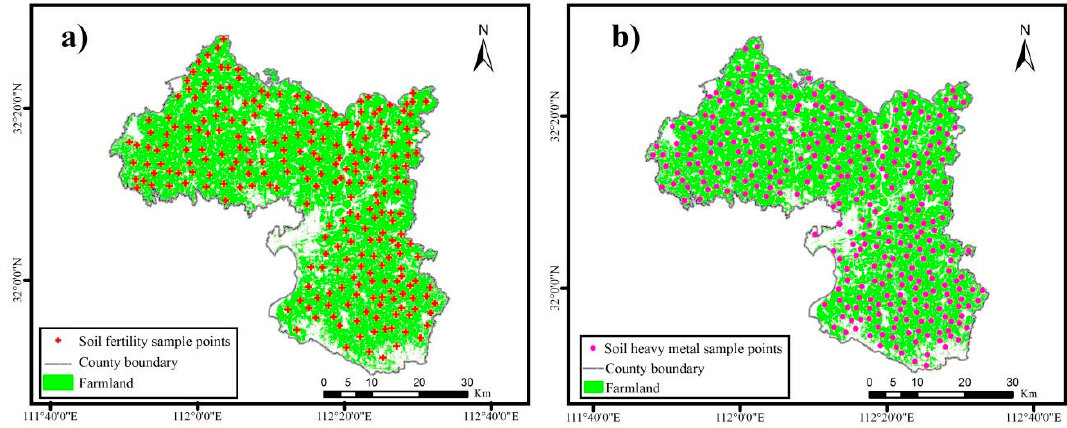
Figure 2. Sampling distribution: ( a ) samples for selection of the soil fertility indicator; ( b ) samples for selection of the soil pollution indicator.